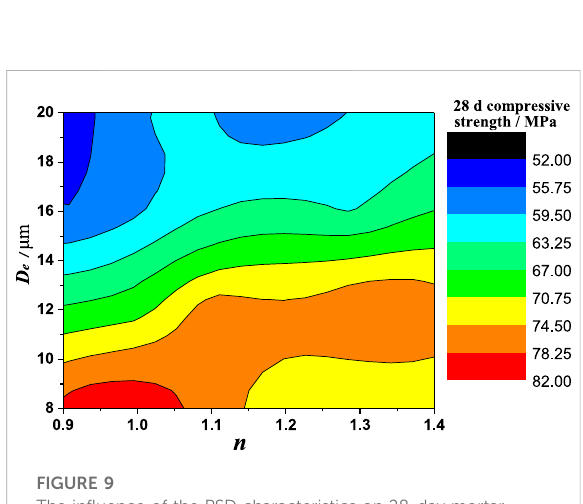
FIGURE 8 The in fl uence of the PSD characteristics on 7-day mortar compressive strength with PCE.